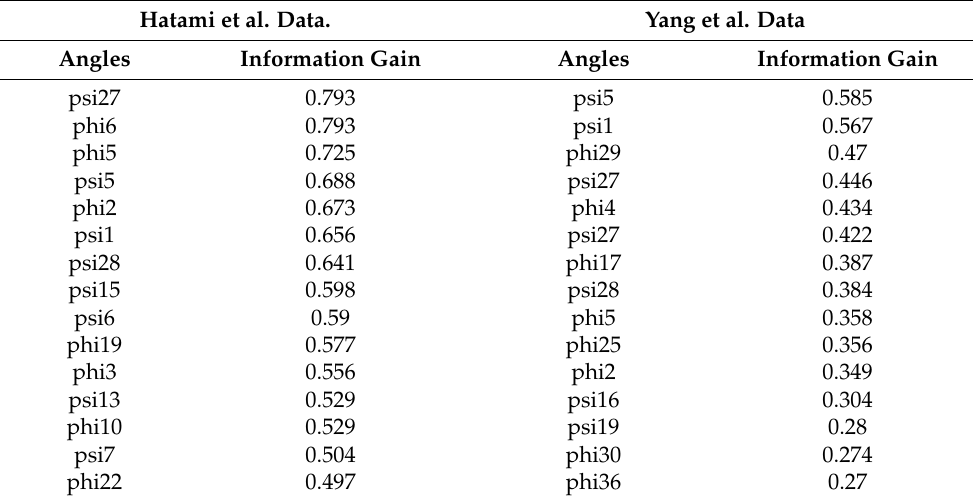
Table 1. Backbone Angles Ranked Based on Aggregation. Hatami et al. Data.